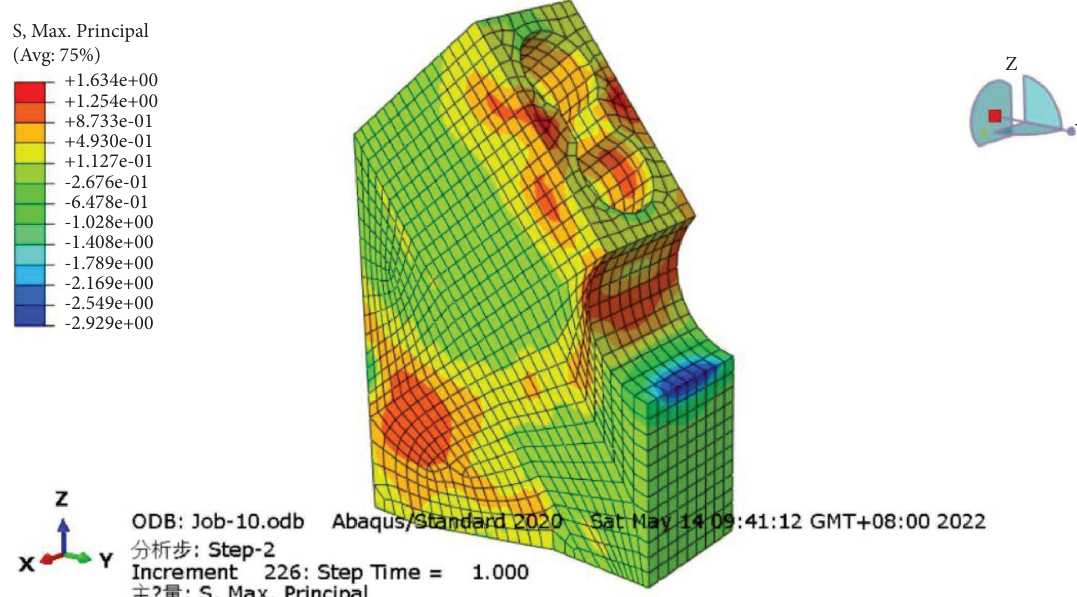
Figure 12: Cloud chart of the principal tensile stress of arch foot without anchorage of condition